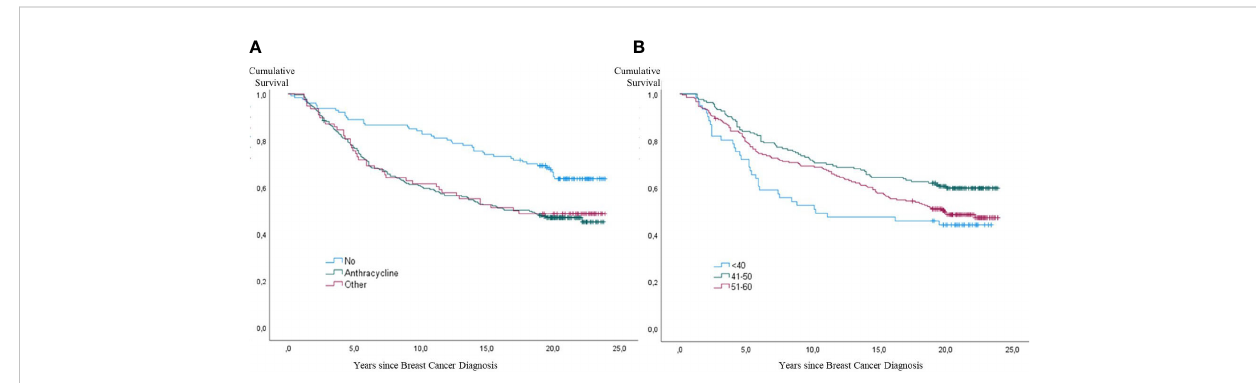
FIGURE 9 Kaplan-Meier curves showing all-cause mortality in 433 patients with lymph node-positive early breast cancer (BC) at diagnosis in the Southeast Healthcare Region, Sweden, January 1, 1998, to December 31, 2002. (A) (Left panel): Cumulative incidence of all-cause mortality by treatment group: Anthracycline Group, other Chemo group, and no Chemo group. (B) (Right panel): Cumulative incidence of all-cause mortality by age group: ≤ 40-years-of-age, 41-50 years, and 51-60 years (p <